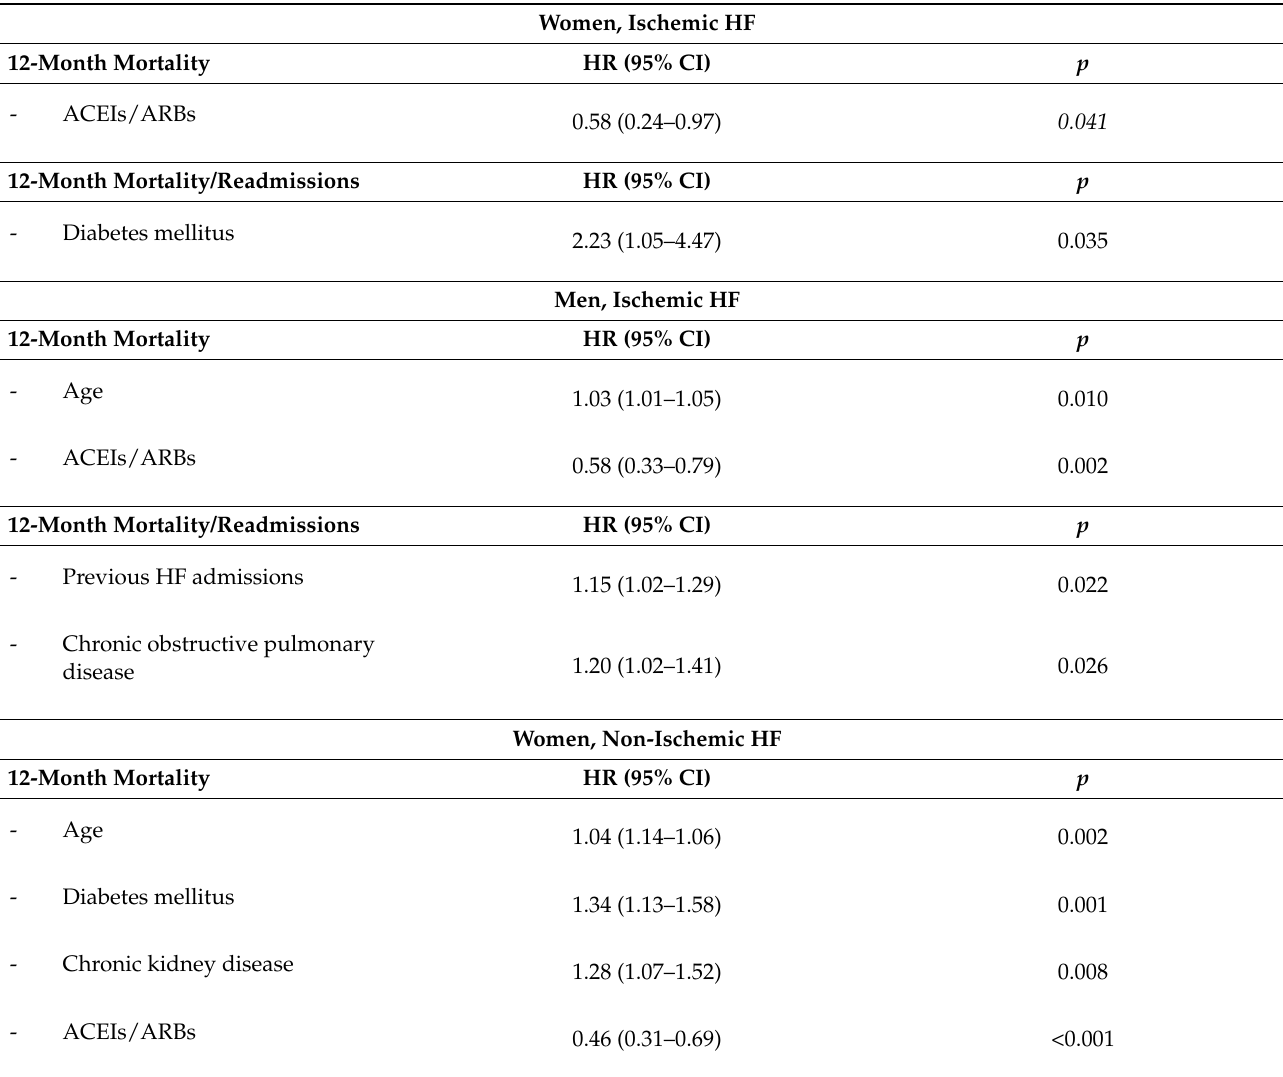
Figure 1. Show Kaplan–Meier survival curves of mortality at 12 months according to HF etiology, in men and women. Table 4. Independent predictors of mortality, and mortality/readmissions at 12 months in patients admitted with heart failure (HF) according to etiology and